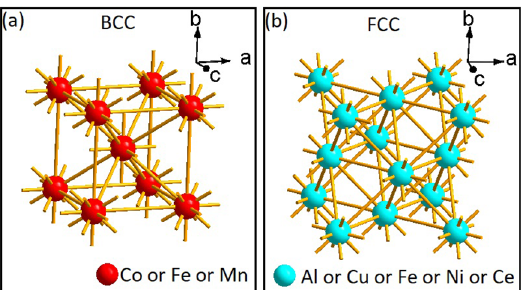
Figure 5. Crystal structure of BCC(a) and FCC(b) phase in alloy